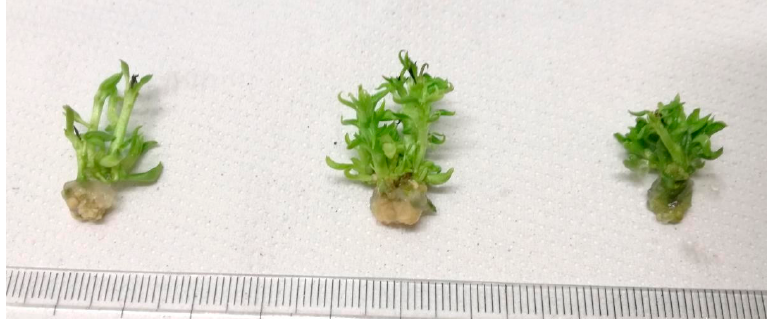
Figure 2. Proliferated explants grown (from left to right) on substrate Control, ON 0.1 (with 0.1 mL L − 1 neem oil added) and ON 0.5 (with 0.5 mL L − 1 neem oil added).